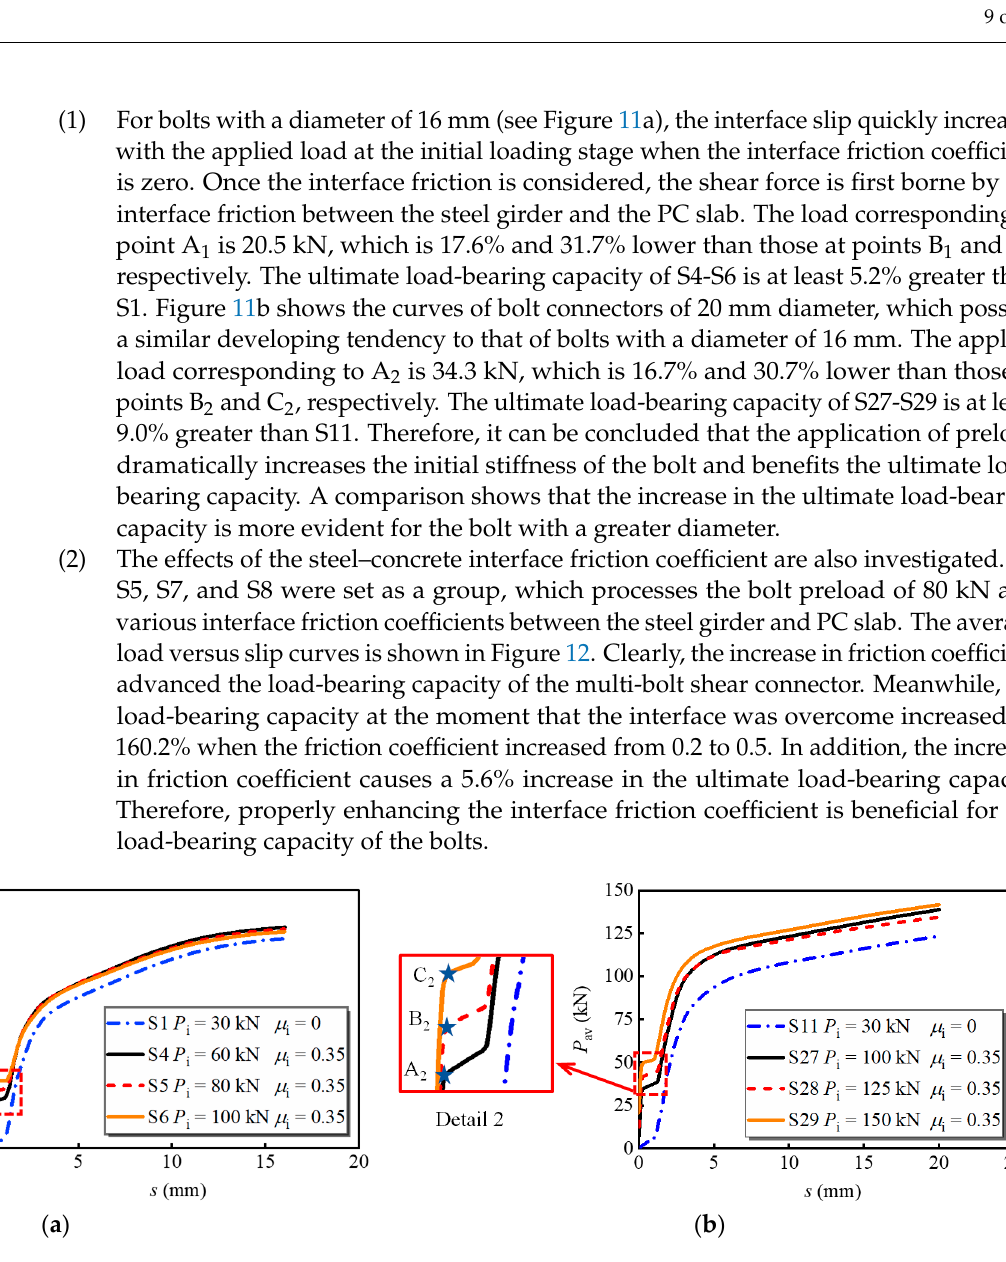
Figure 10. Average load versus slip curves for models with different concrete compressive strength.